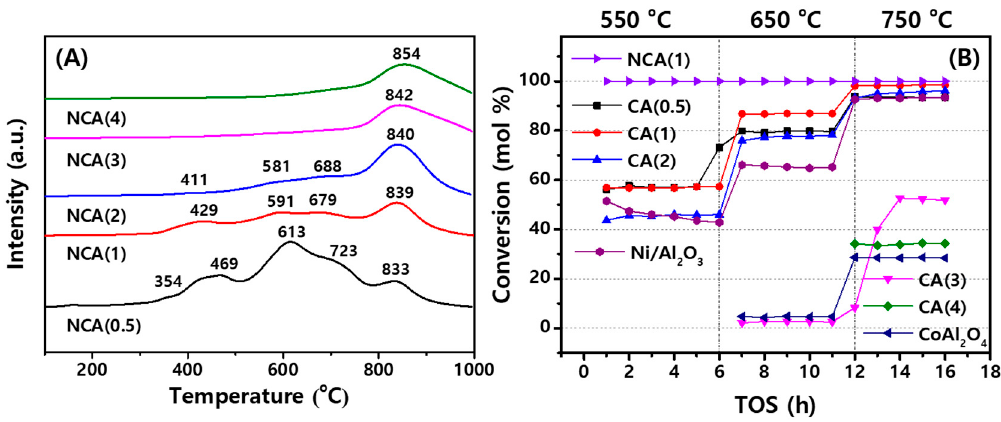
Figure 2. ( A ) Reduction behaviors of the NCA catalysts measured by temperature programmed reduction (TPR) analysis, ( B ) Results of preliminary activity measurement of the Co 3 O 4 -Al 2 O 3 (CA) supports with reference samples such as Ni/Al 2 O 3 and CoAl 2 O 4 for C 3 H 8 conversion with time on stream (h) at the reaction condition of T = 550–650–750 °C, P = 0.1 MPa and SV = 100,800 L/(kg cat ∙ h) by using a feed gas composition of C 3 H 8 /N 2 /H 2 O = 1:4:9.